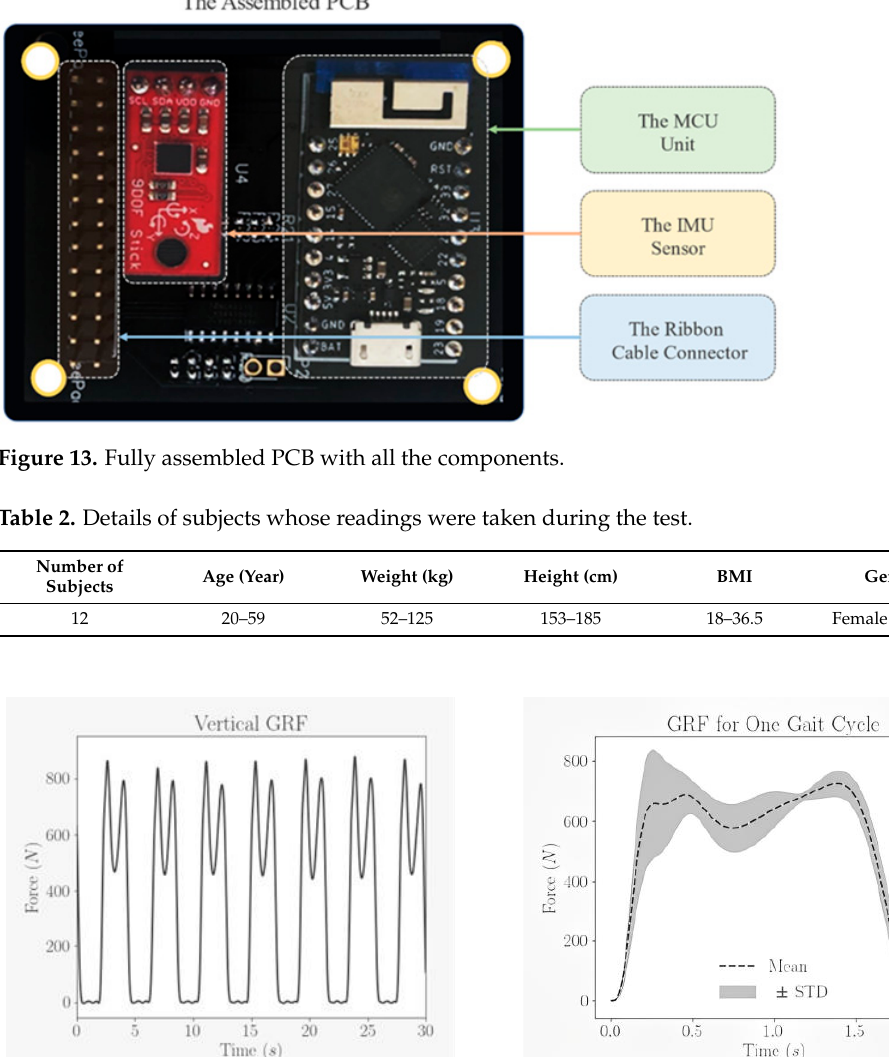
Figure 14. Ground Reaction Force characteristics for one trial and mean of all gait cycles.